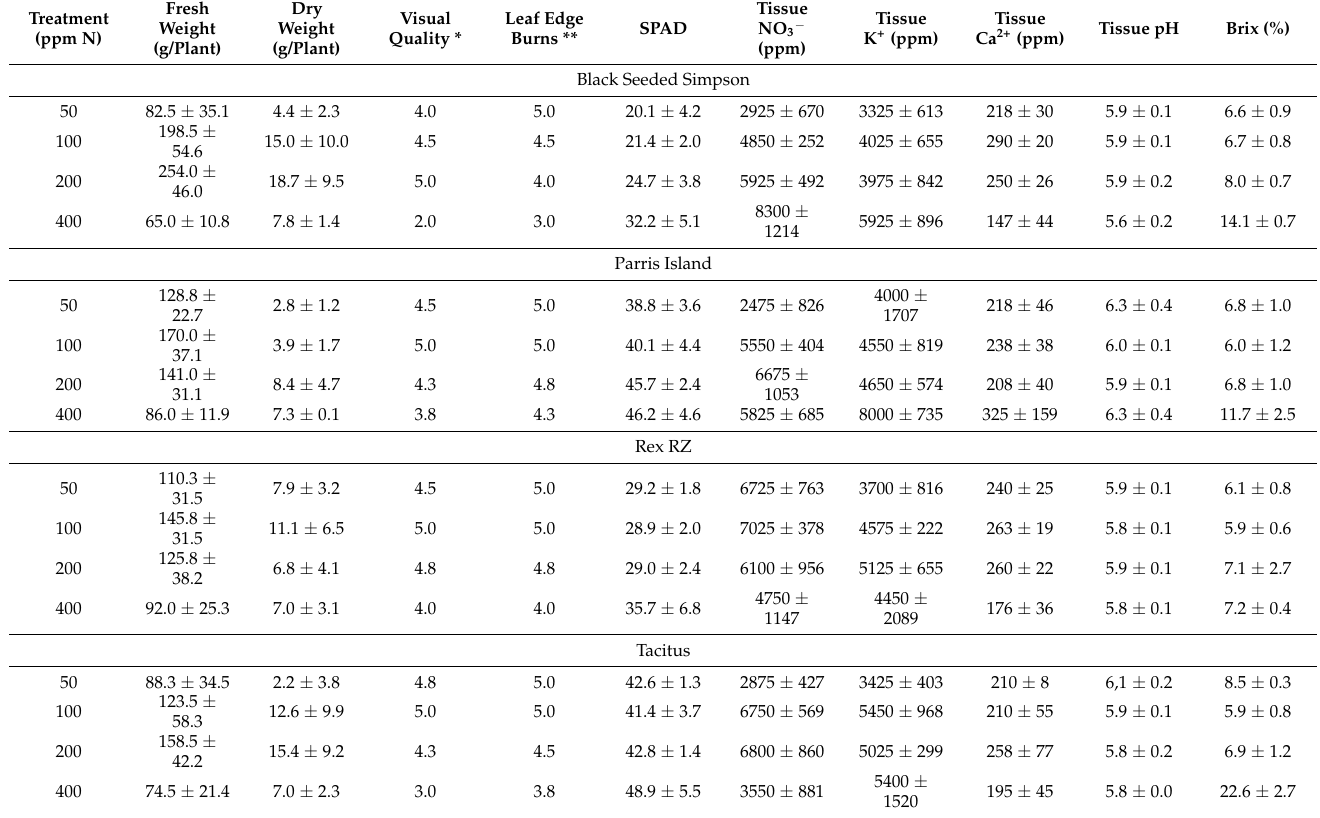
Table 3. Influence of nutrient concentrations on tissue mineral composition, pH, and solids content of four different lettuce cultivars grown in the NFT